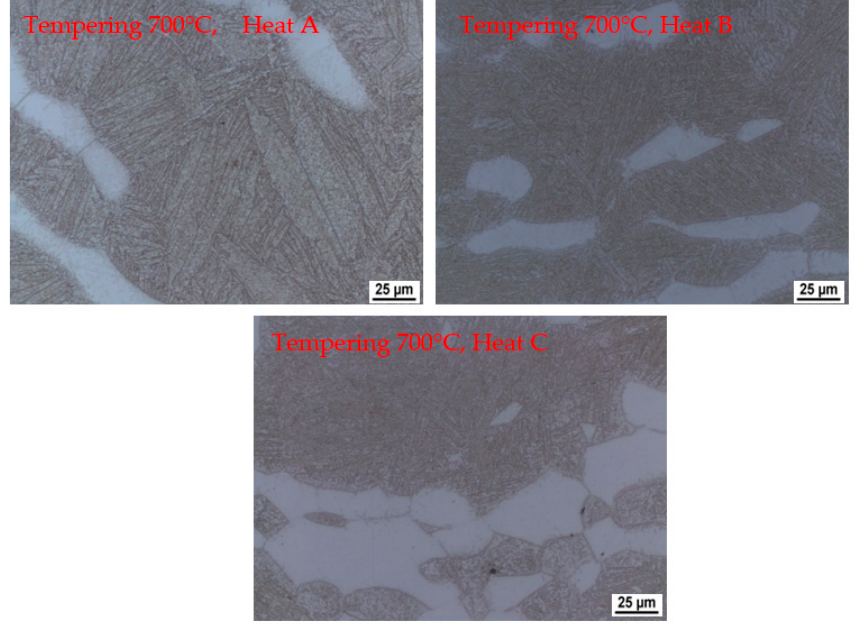
Figure 19. Microstructures of individual heats during tempering. Tempering temperature of 700 °C—heating rate 3 °C/min. Table 4. Results of the spot analysis of the chemical composition of individual phases or mixtures. All in